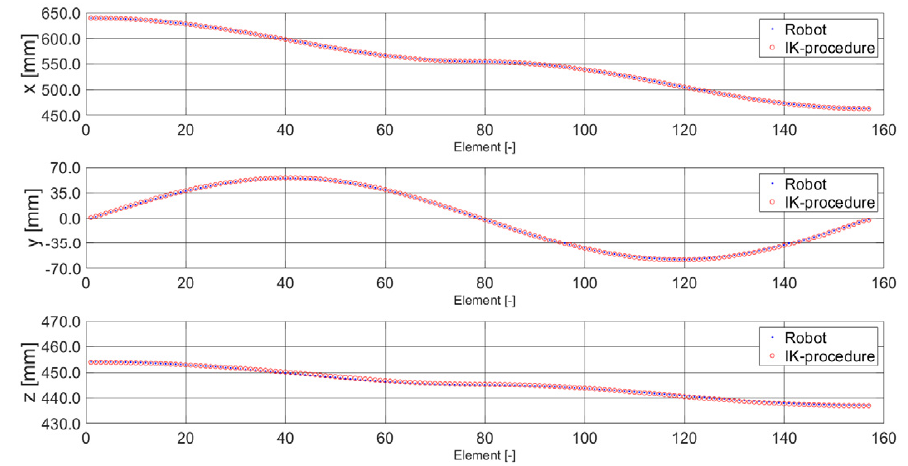
Figure 17. S-shape in the X-Y plane: X-, Y-, Z-axes Robot vs. IK procedure.